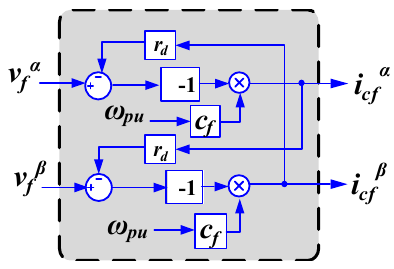
Figure 5. Estimation of the capacitor current based on the estimated capacitor voltage.